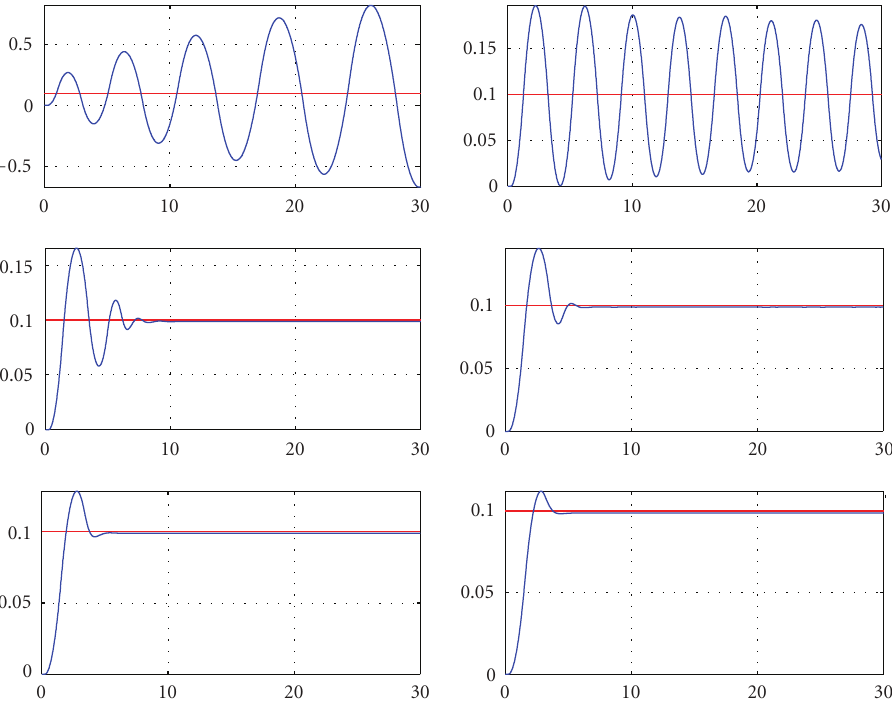
Figure 6: system responses with increasing T p